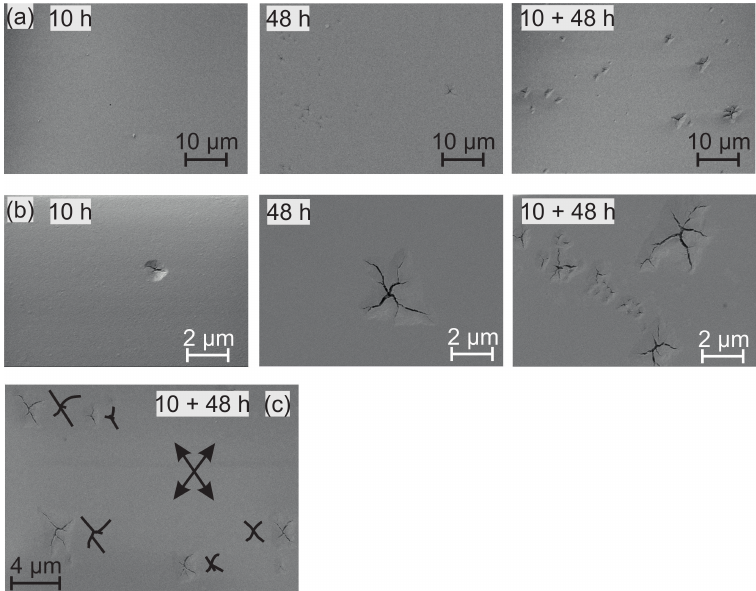
Figure 2. SE-SEM images of the heated substrates at low ( a ) and high ( b ) magnification. ( c ) SE-SEM image of the 10 + 48 h sample. The arrows indicate the two main directions of the cracks in the substrate.